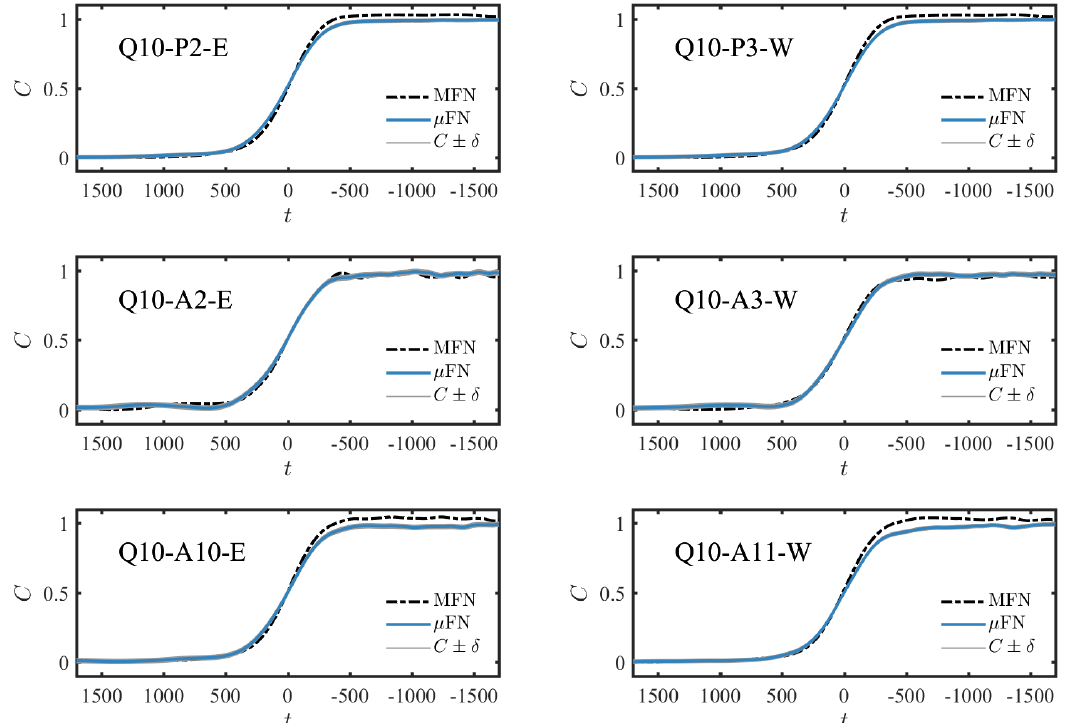
Figure A5. Measured breakthrough curves in the MFN (dashed line) and µ FN (solid line) at upstream (east) and downstream (west) locations on the same primary (P2–P3), secondary (A10–A11) and tertiary (A2–A3) fracture at Q = 10 µ